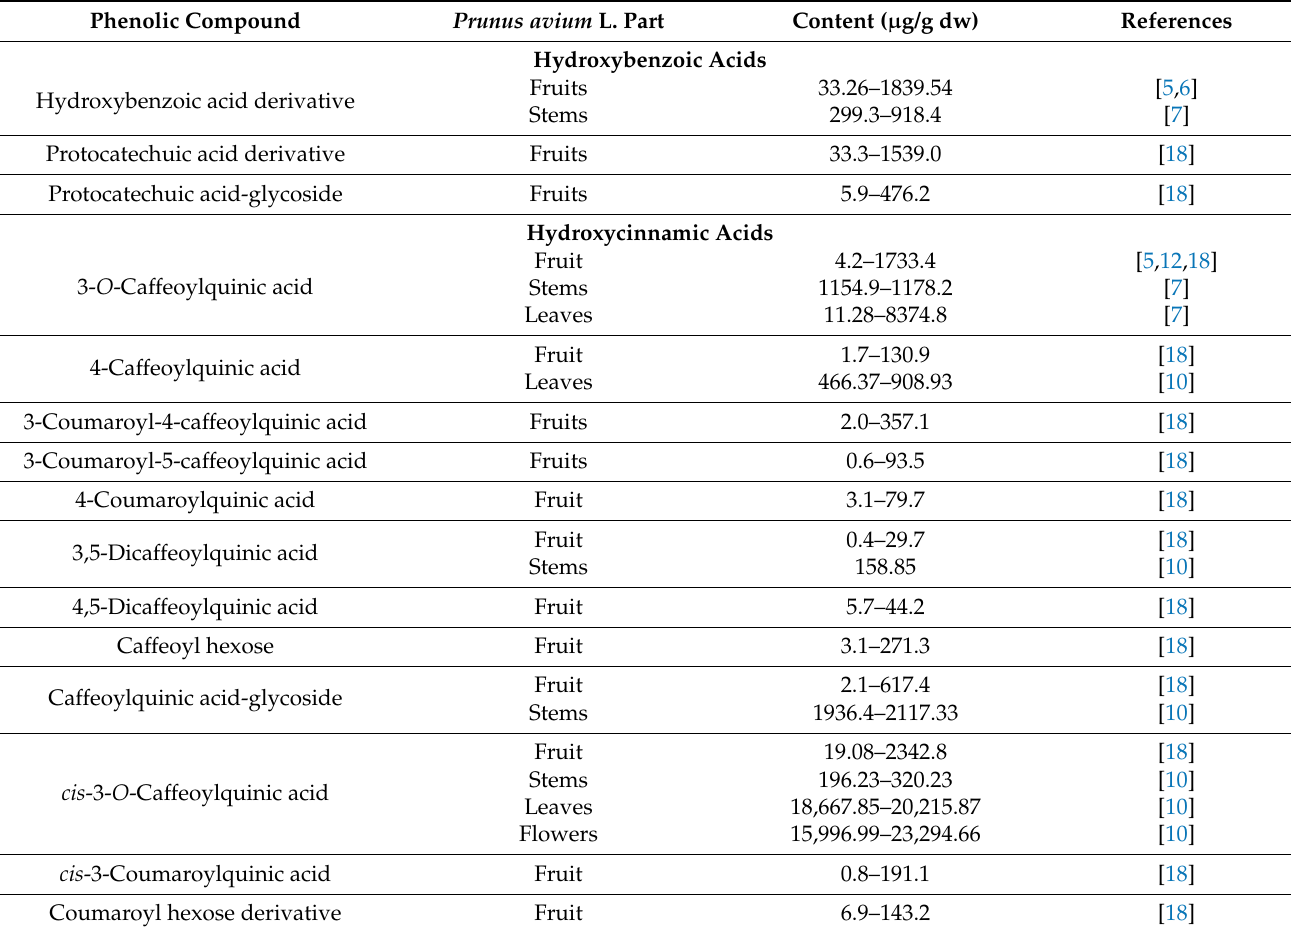
Table 3. Main phenolic compounds detected and quantified in P. avium L. fruits and their by-products. Phenolic Compound Prunus avium L.